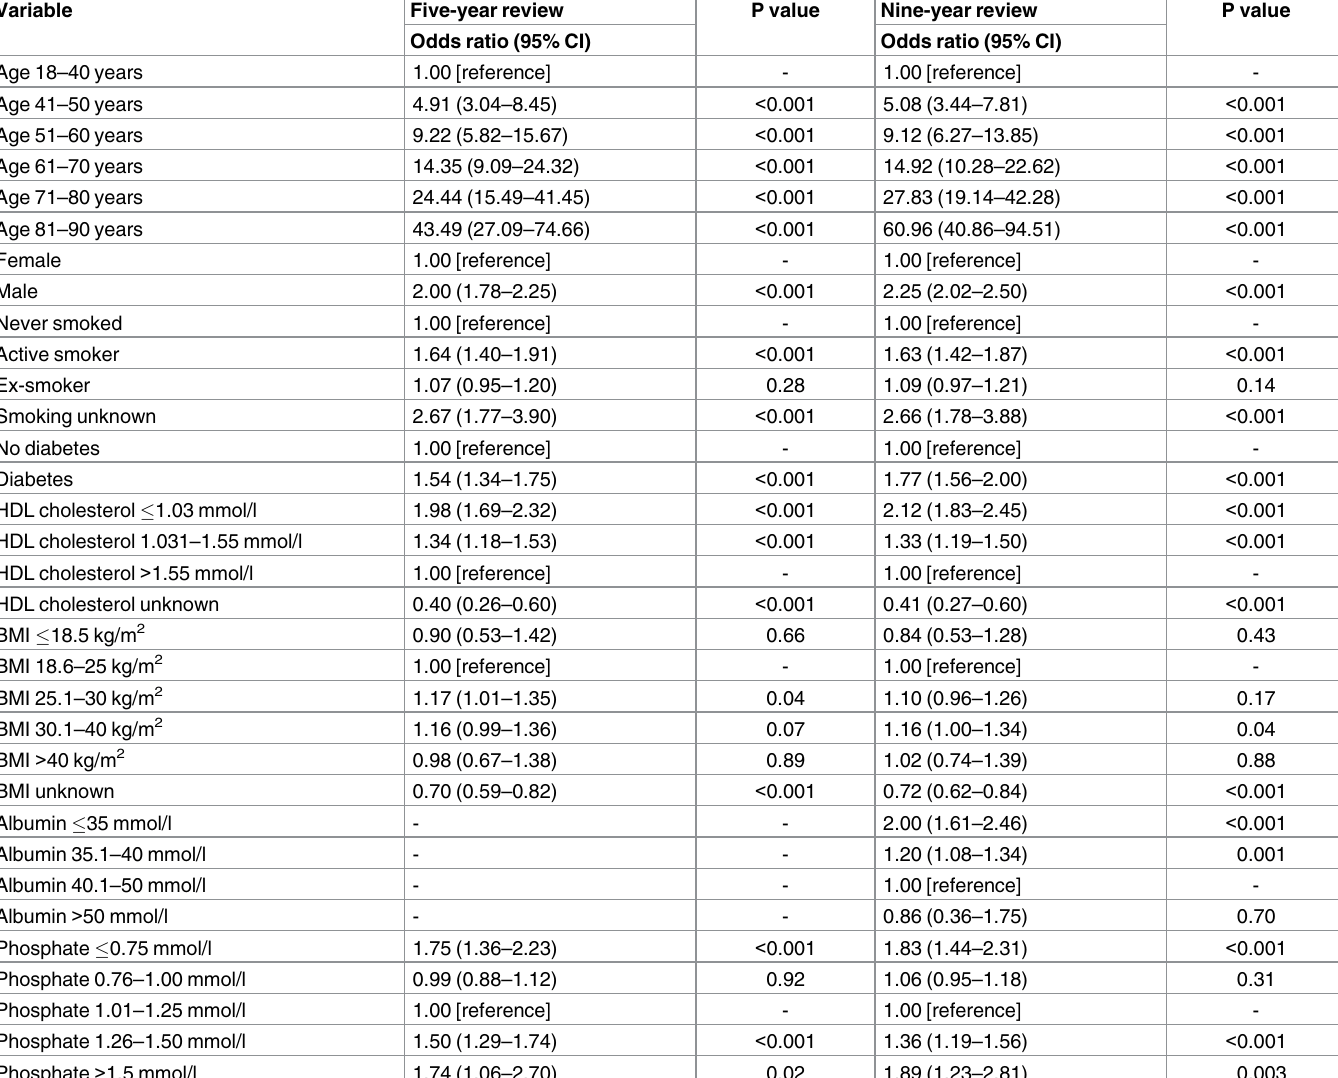
Table 2. Results of stepwise logistic regression analyses utilising the Bayesianinformation criterion (BIC). Odds ratios represent the odds of a pri- mary composite cardiacoutcome at five years (n = 59880)and nine years (n = 22028)after initial serum phosphate measurement. Serum albuminwas not retainedduringthe stepwiseapproachat 5 years. CI = confidenceinterval. P values < 0.05 were deemed significant. Receiveroperatingcharacteristic curve (ROC C) statistics were 0.78 and 0.79 for the five-year and nine-yearreviews,